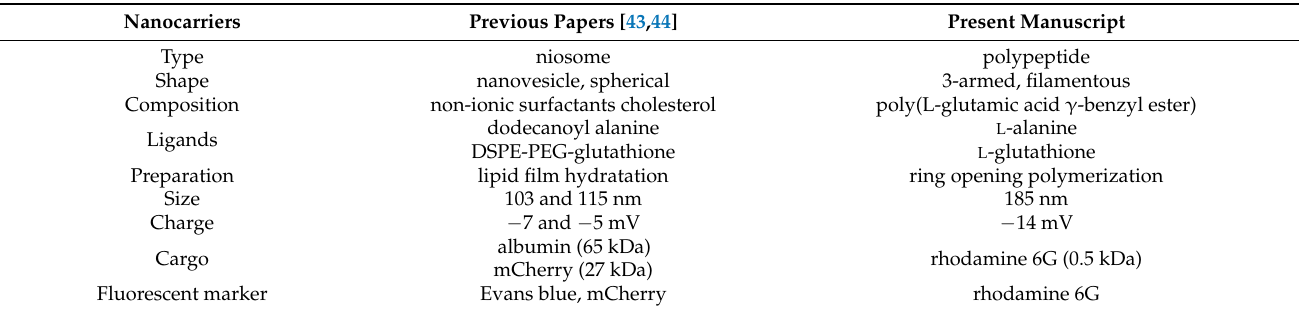
Table 2. Main differences between the physico-chemical properties of nanoparticles in our previous works [43,44] and the present